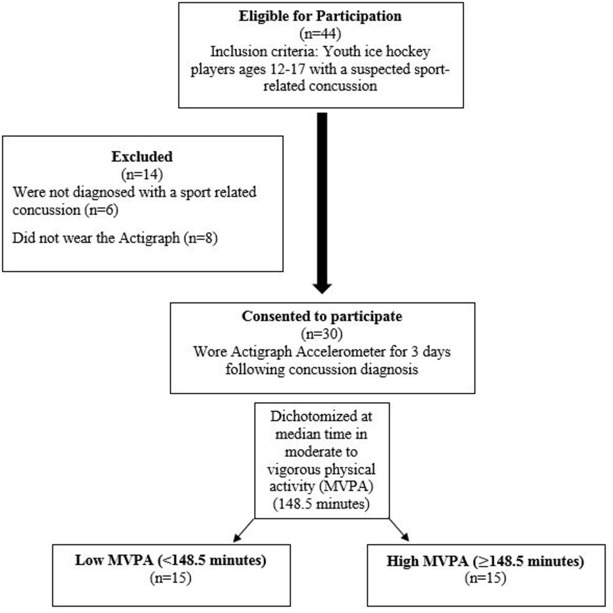
Consent flowchart.